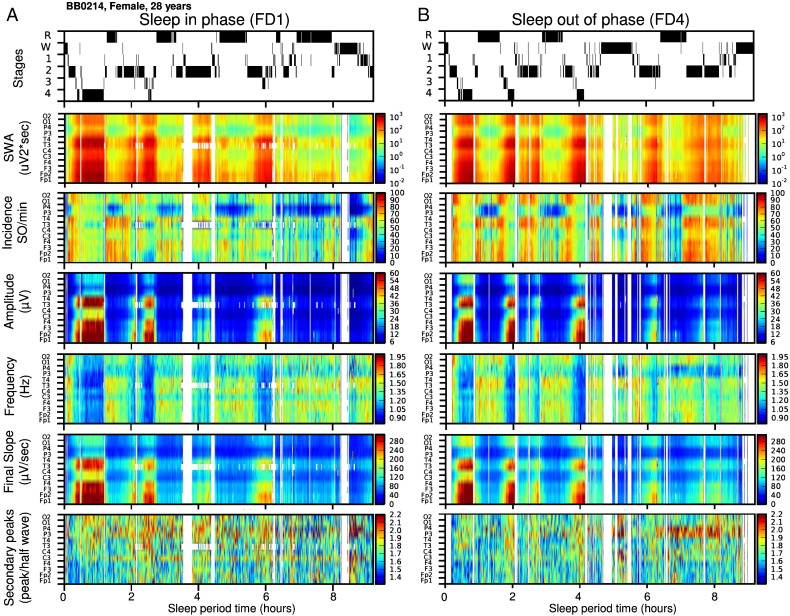
A representative example of the effect of sleep timing on sleep structure and on the time course of multiple slow wave (SW) parameters across each studied EEG derivation (BB0214, Female, 31 years) presented on an interpolated color map.A. Sleep stages during FDn1 when sleep was scheduled to occur at the habitual times, and the interpolated map of corresponding time course (1 min resolution) of slow wave activity (SWA: 0.5–4 Hz), incidence, absolute amplitude, duration, absolute mean slope of the individually detected negative half-waves (> 5 μV, 0.5–4 Hz) of SWs across all studied EEG derivations.B. Sleep stages and the time course of studied SW parameters across all EEG derivations as measured during the 9 hour and 20 minute sleep period FDn4 scheduled 180o (~ 12 h) out of phase with habitual sleep time.